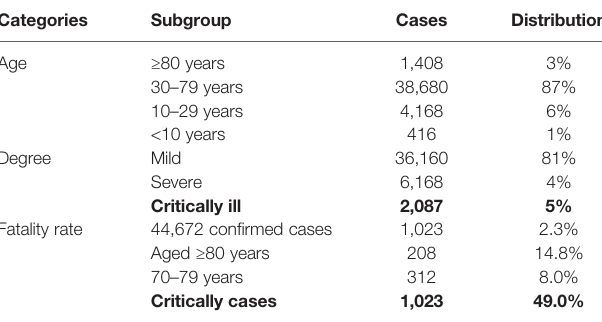
TABLE 1 | The distribution of age, degree, and fatality rate of COVID-19